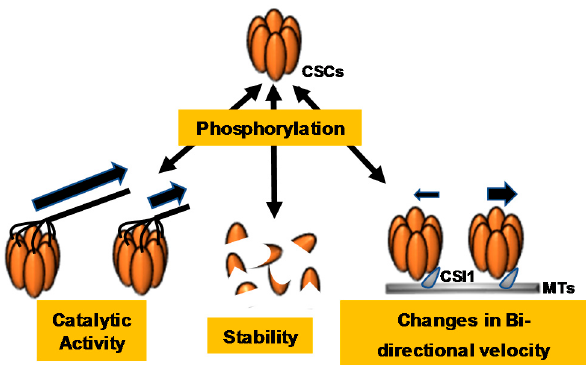
Figure 3. Cellulose synthase complex (CSC) phosphorylation events dynamically regulate CSC catalytic activity, stability, and bidirectionality. Cellulose synthase A7 (CESA7) phosphorylation leads to rapid degradation of the protein, indicating that CESA7 phosphorylation regulates protein stability. CESA1, CESA3, and CESA5 phosphorylation regulate changes in CSC velocities and constant motility, indicating that phosphorylation of these CESAs regulates CSC catalytic activity and bidirectional motility.